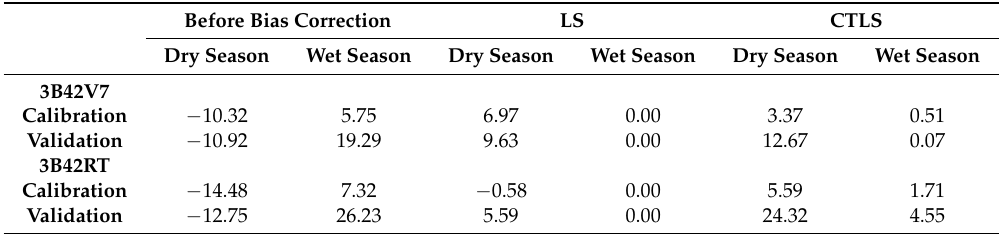
Table 11. The average PBIAS score’s performance of calibration and validation for CTLS with TMPA 34B42V7 and TMPA 3B42RT during the dry and wet seasons. Before Bias Correction